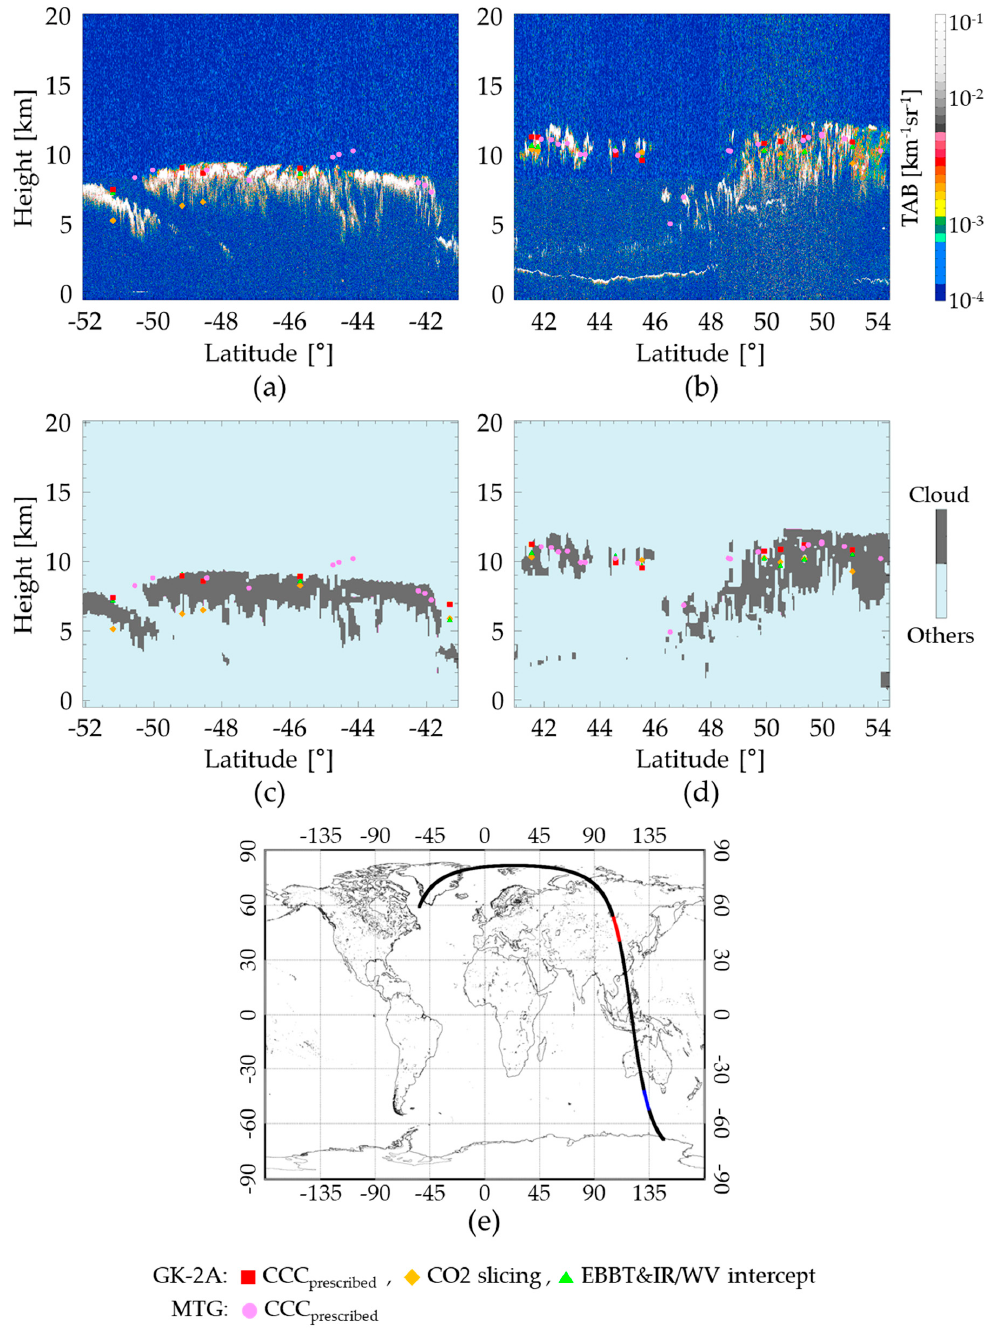
Figure 9. Comparison of AMV heights and Cloud-Aerosol Lidar with Orthogonal Polarization (CALIOP) level 1 and 2 lidar products for 05:40 UTC on 21 July 2016. ( a ) CALIOP 532 total attenuated backscatter (TAB) and ( c ) level 2 cloud profiles for the red segment of ( e ). ( b ) CALIOP 532 attenuated backscatter and ( d ) level 2 cloud profiles for the blue segment of ( e ). Symbols represent prescribed CCC heights ( ● ) of MTG AMVs and the prescribed CCC heights ( ■ ), specific CO 2 slicing heights ( ◆ ), and EBBT and IR/WV intercept heights ( ▲ ) of GK-2A AMVs, respectively. ( e ) The corresponding track of CALIOP is also plotted. No collocated AMV data were available for 12:10 UTC on 21 July 2016.